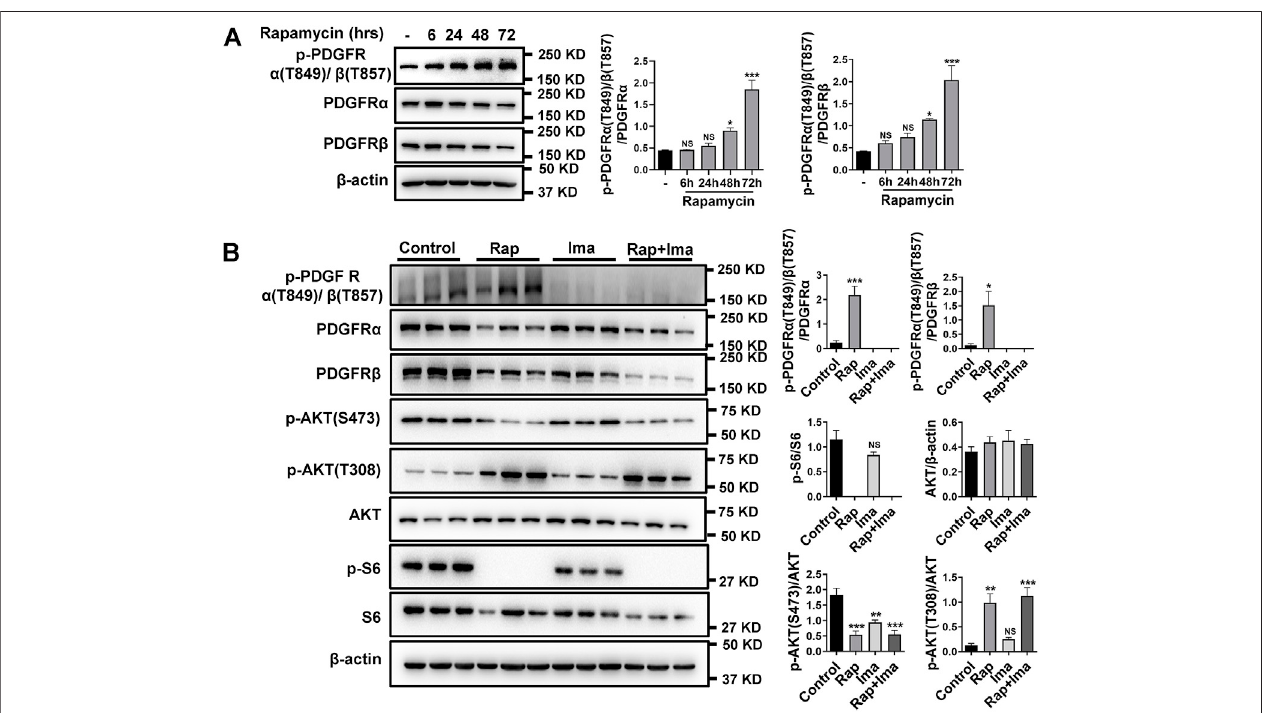
FIGURE 2 | Imatinib inhibits phosphorylation of PDGFR α / β induced by rapamycin in hPASMCs. (A) hPASMCs were treated with 100 nM rapamycin for the indicated times and analyzed by immunoblotting for the proteins level of p-PDGFR α / β , PDGFR α , PDGFR β . (B) Immunoblotting analyses of p-PDGFR α / β , PDGFR α , PDGFR β , p-AKT (S473), p-AKT (T308), p-S6 and S6 in hPASMCs treated with vehicle (Control), 100 nM rapamycin (Rap), 5 uM imatinib (Ima) and 100 nM rapamycin + 5 uMimatinib(Rap+Ima)for48 h.Dataarepresentedasthemean ± SE.One-wayANOVAwasusedforstatisticalanalysis.NSmeansnotsigni fi cant.*** p < 0.001, ** p < 0.01, * p < 0.05 versus